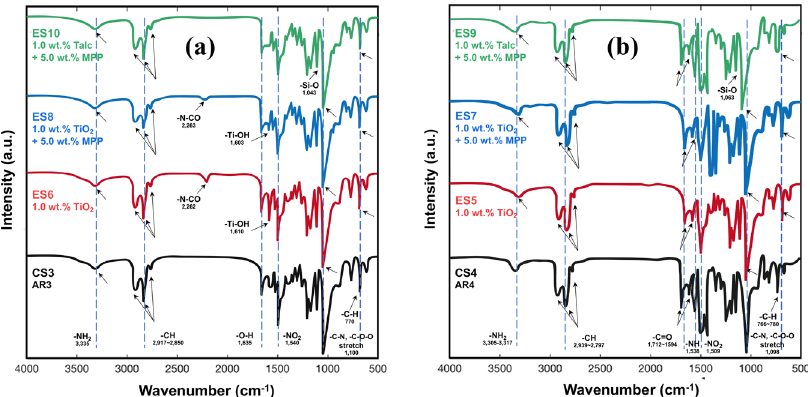
Fig. 1 FTIR spectrum of coating samples a AR3 matrix (IPDI base) series with aromatic diamine only and b AR4 matrix series (MDI base) with both aromatic diamine and aromatic